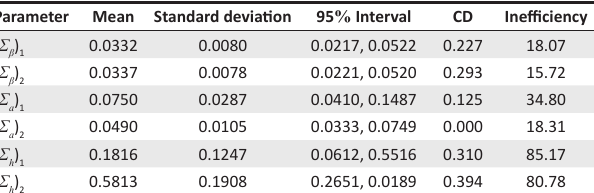
TABLE 1: Estimated results of the selected parameters in the time-varying parameter vector autoregressive model. Parameter Mean Standard deviation 95 % Interval CD